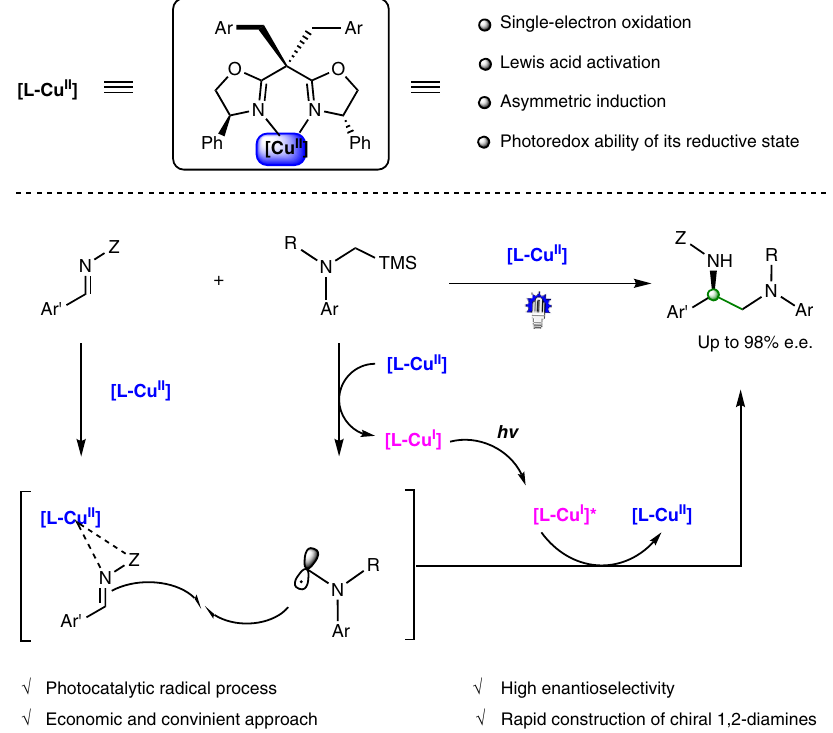
Fig. 1 Overview of this work, photocatalytic enantioselective α -aminoalkylation of acyclic imine derivatives by a chiral copper